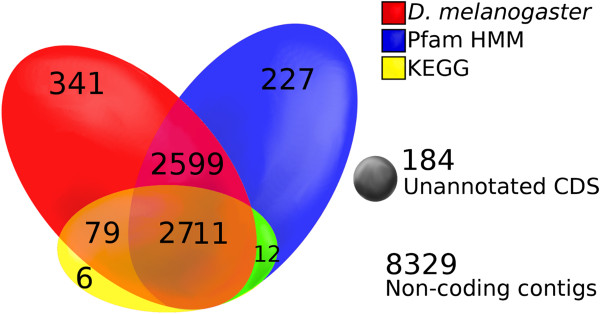
Venn diagram for the annotation obtained for the Musca domestica ALHF strain predicted gene set. Overlapping ellipses represent predicted genes from the Pfam-A (v26.0), the Drosophila melanogaster proteome (v. r5.46), and the Kyoto Encyclopedia of Genes and Genomes (KEGG) automatic annotation server (KAAS) that could be annotated in two or more of the databases used to predict gene function. An e-value threshold for homology detection was fixed at 10-20 for the Pfam and blastx analyses and at 10-5 for KEGG. The circles excluded from the overlapping ellipses represent sequences which contained the coding region, but had no homologs in any of the three databases used for gene prediction.